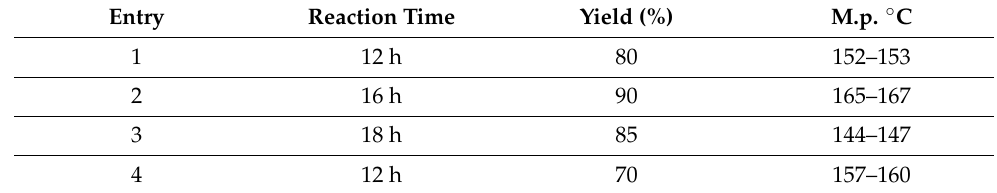
Table 1. Reaction Time used in the synthesis of DEXT 1–4 pyrrolidones yield and melting